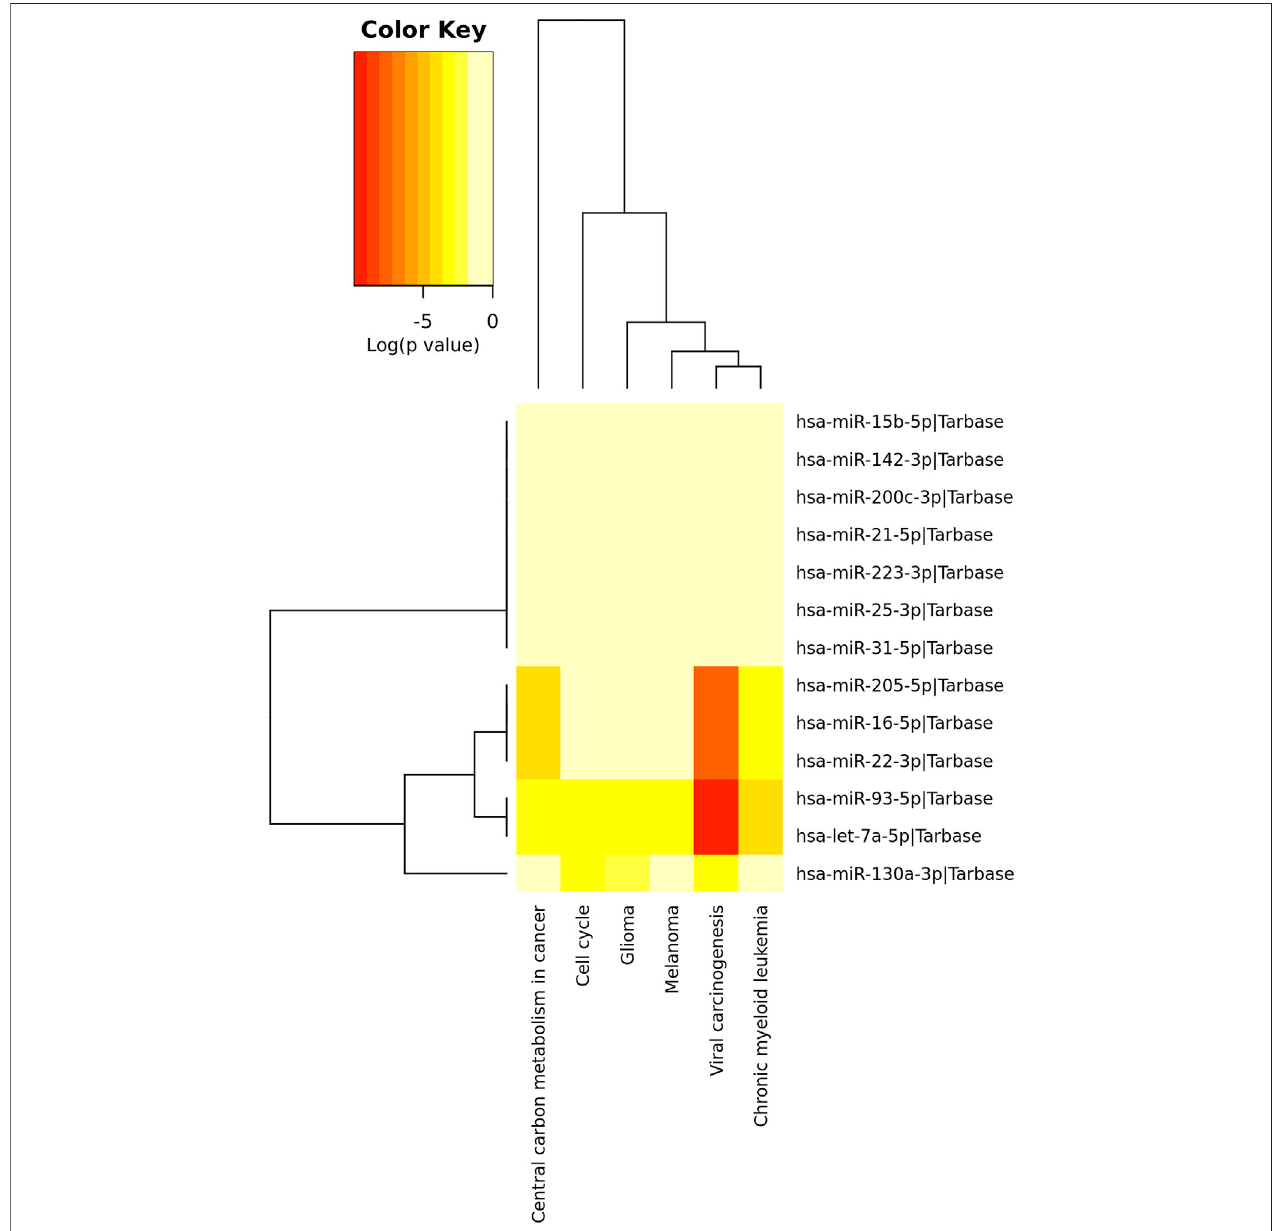
FIGURE4| Toppathwaysidenti fi edbythetarbasealgorithm( p < 0.05;DIANA/miRPathv.3).RedcolorsindicateastrongerroleofthemiRNAsonagivenpathways as compared to the lighter colors.